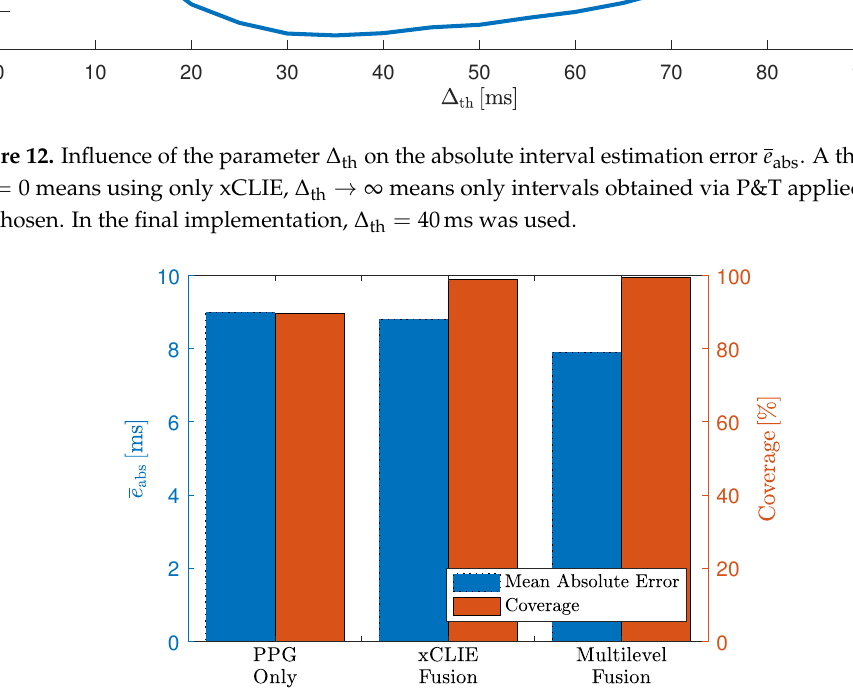
Figure 13. Comparison of xCLIE and multilevel fusion. PPG is listed as best performing individual modality in terms of error and